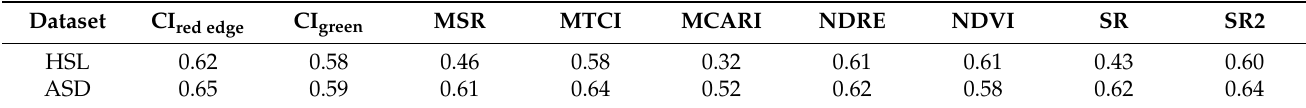
Table 3. R 2 values between spectral indices and N concentrations for the HSL and ASD